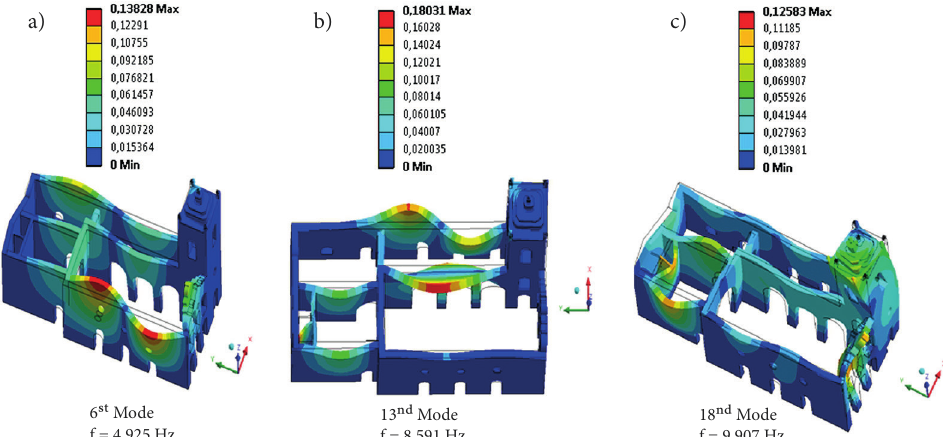
Fig. 14. 6th, 13th and 18th modal shapes of the Nossa Senhora das Dores Church